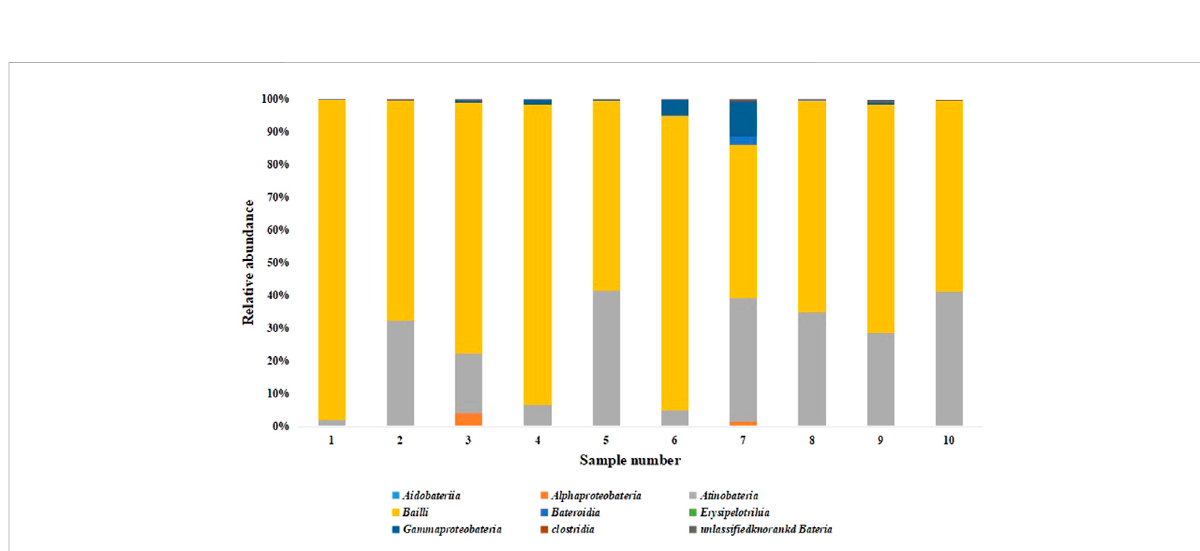
FIGURE 6 Relativeabundanceofbacterialphylum.Note:1to5wererespectivelyaddedwaterandfermentedfor0d,2d,4d,6d,8d,6-10werefollowed by medium fermentation for 0 d, 2 d, 4 d, 6 d, 8